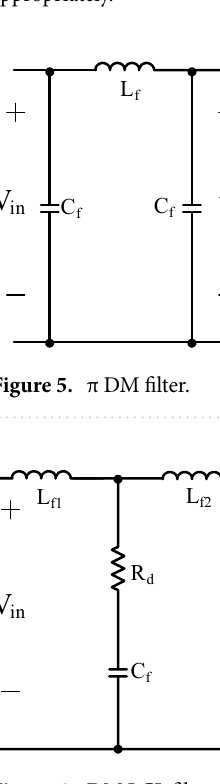
Figure 6. DM LCL